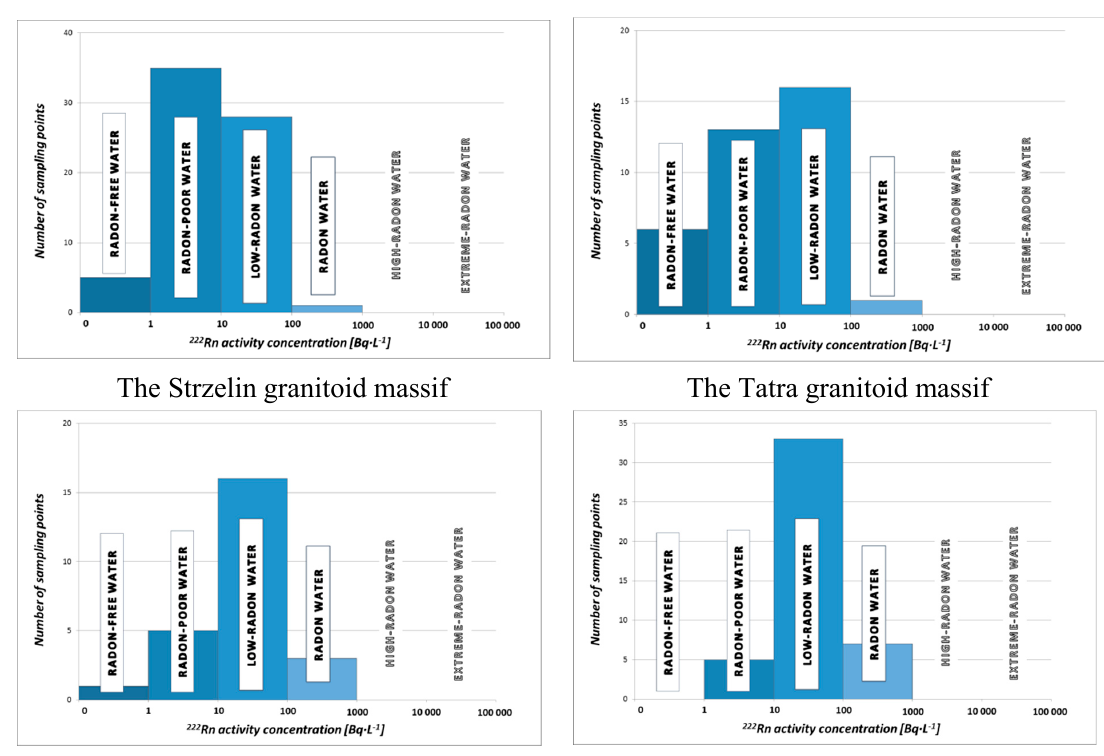
Figure 8. Histograms of 222 Rn activity concentration in groundwaters from granitoid massifs of Poland. Names of groundwater types by 222 Rn content by Przylibski [2].